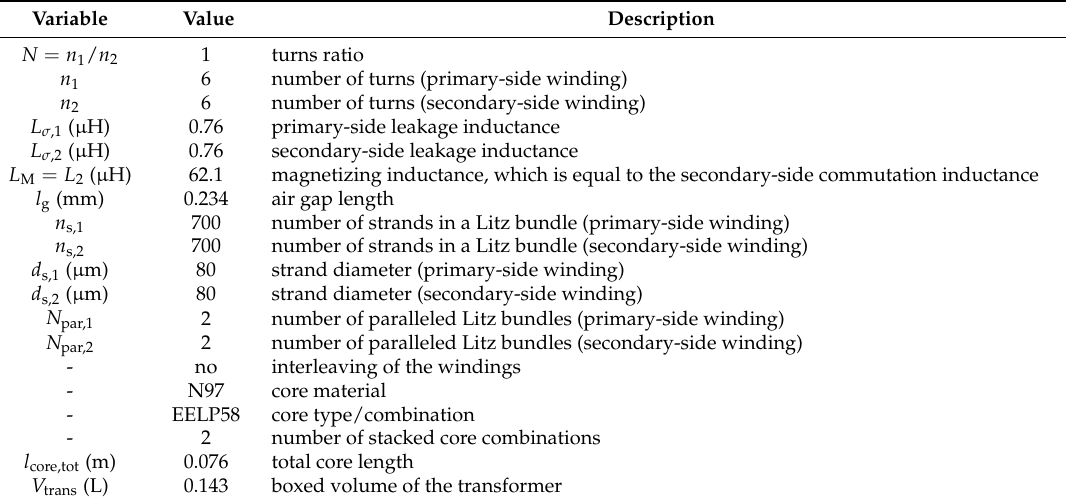
Table A6. Design values for the HF ac-link transformer.